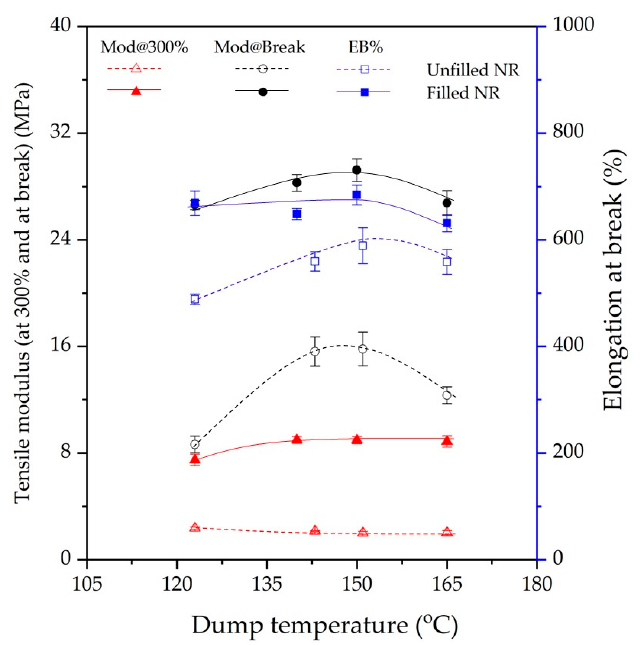
Figure 8. Tensile modulus (at 300% strain and at break) and elongation at break of gum and filled NR compounds subjected to various dump